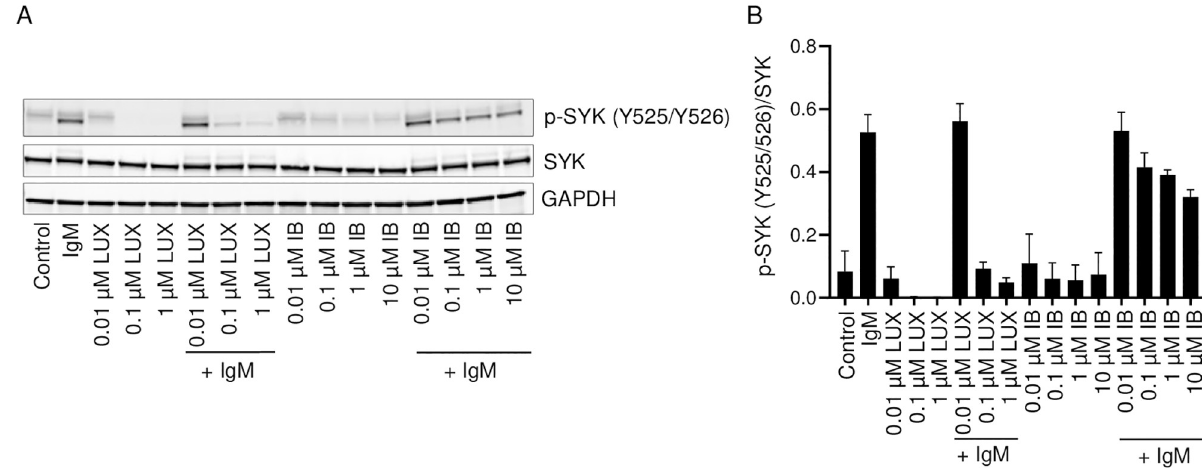
Fig 3. Effect of LUX and IB on anti-IgM-induced activation of SYK in SU-DHL-6 cells. SU-DHL-6 cells were pre-treated for 2 h with either LUX or IB and then stimulated with anti-human IgM or left unstimulated. (A) Western blot analysis of whole cell lysates for p-SYK (Y525/Y526), SYK, and GAPDH; representative blots are shown. (B) Quantification of intensity of bands in Western blots shown in A. Data is mean ± SEM of data from 2 independent experiments.